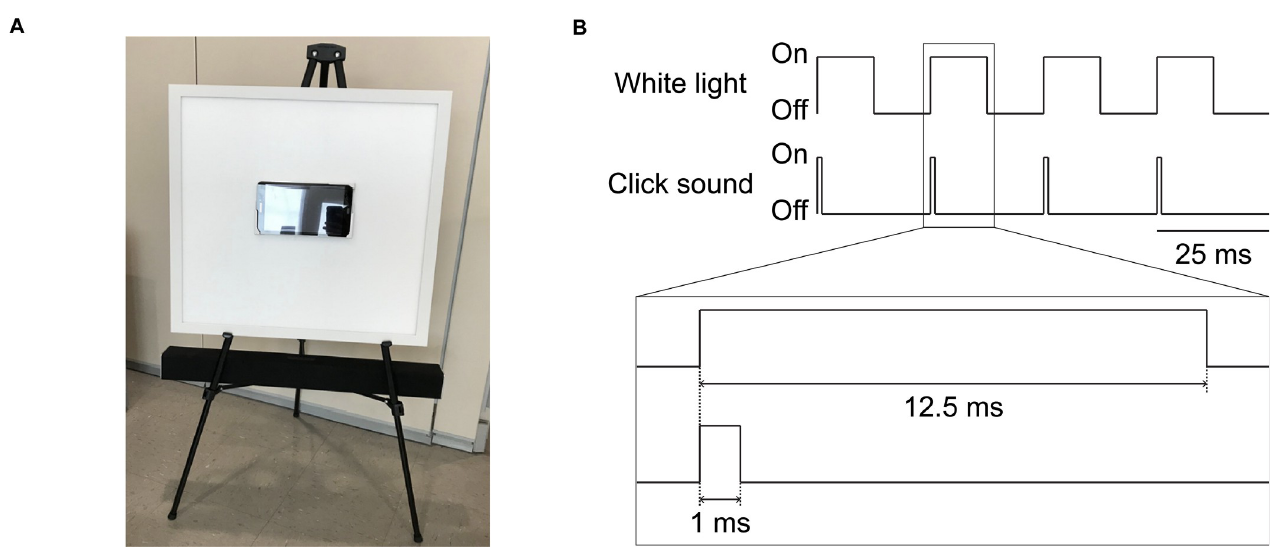
Fig 2. GENUS device and 40Hz stimulation schematic. (A) Light and sound stimulation device. The white board is a programmable LED light display panel that measures at 2 feet x 2 feet. Sitting at the center of the light panel is a tablet loaded with videos to keep the viewer’s attention on the device. The black bar below the light panel is the programmable soundbar audio system. The device is supported by the legs of a black easel and positioned so the tablet is eye level when the viewer is seated 5 feet away. (B) Schematic of the electrical signals that turn the white light and the click sound pulses on or off for concurrent light and sound stimulation at